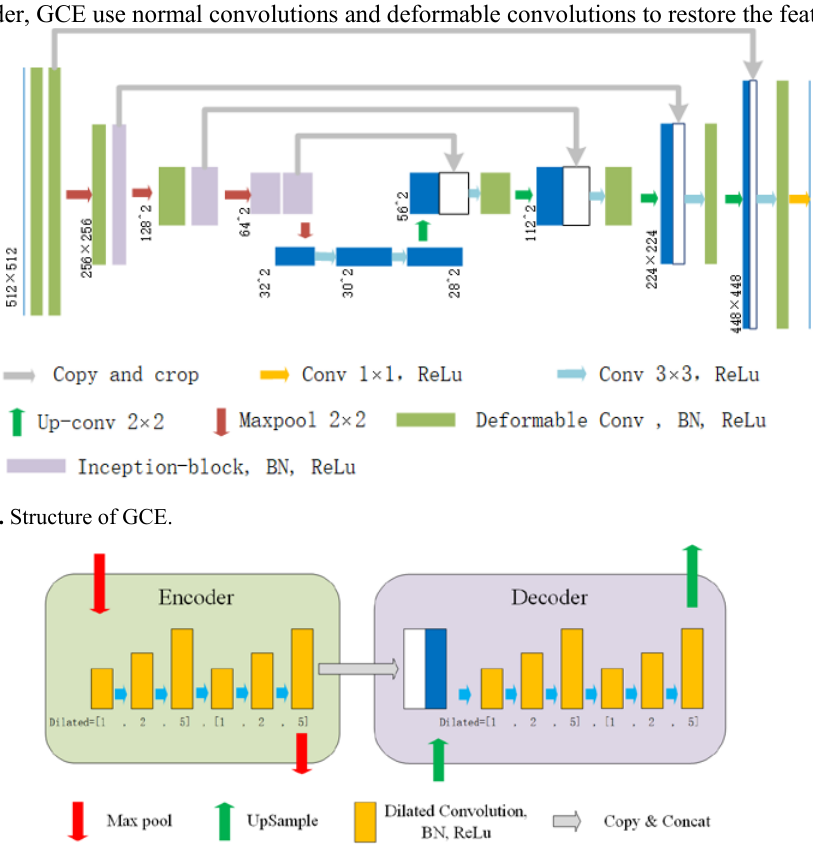
Fig. 3. Encoder & decoder of